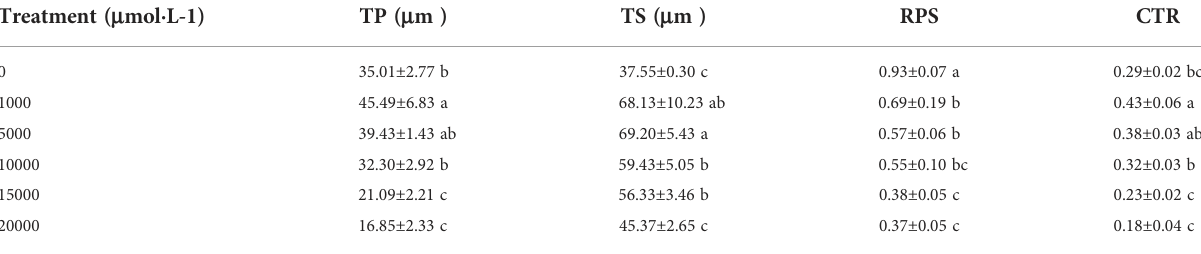
TP, the thickness of palisade tissue; TS, The thickness of sponge tissue; RPS, The ratio of palisade tissue/ spongy tissue; CTR, cell tense